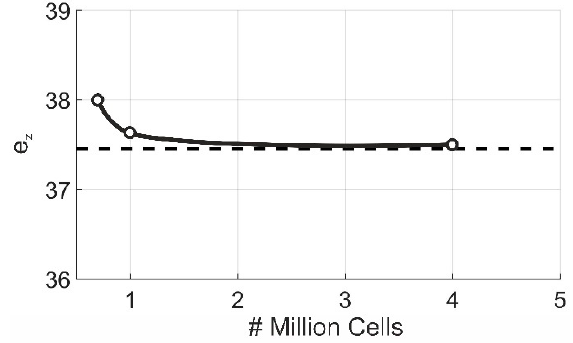
Figure 5. Mesh sensibility analysis.